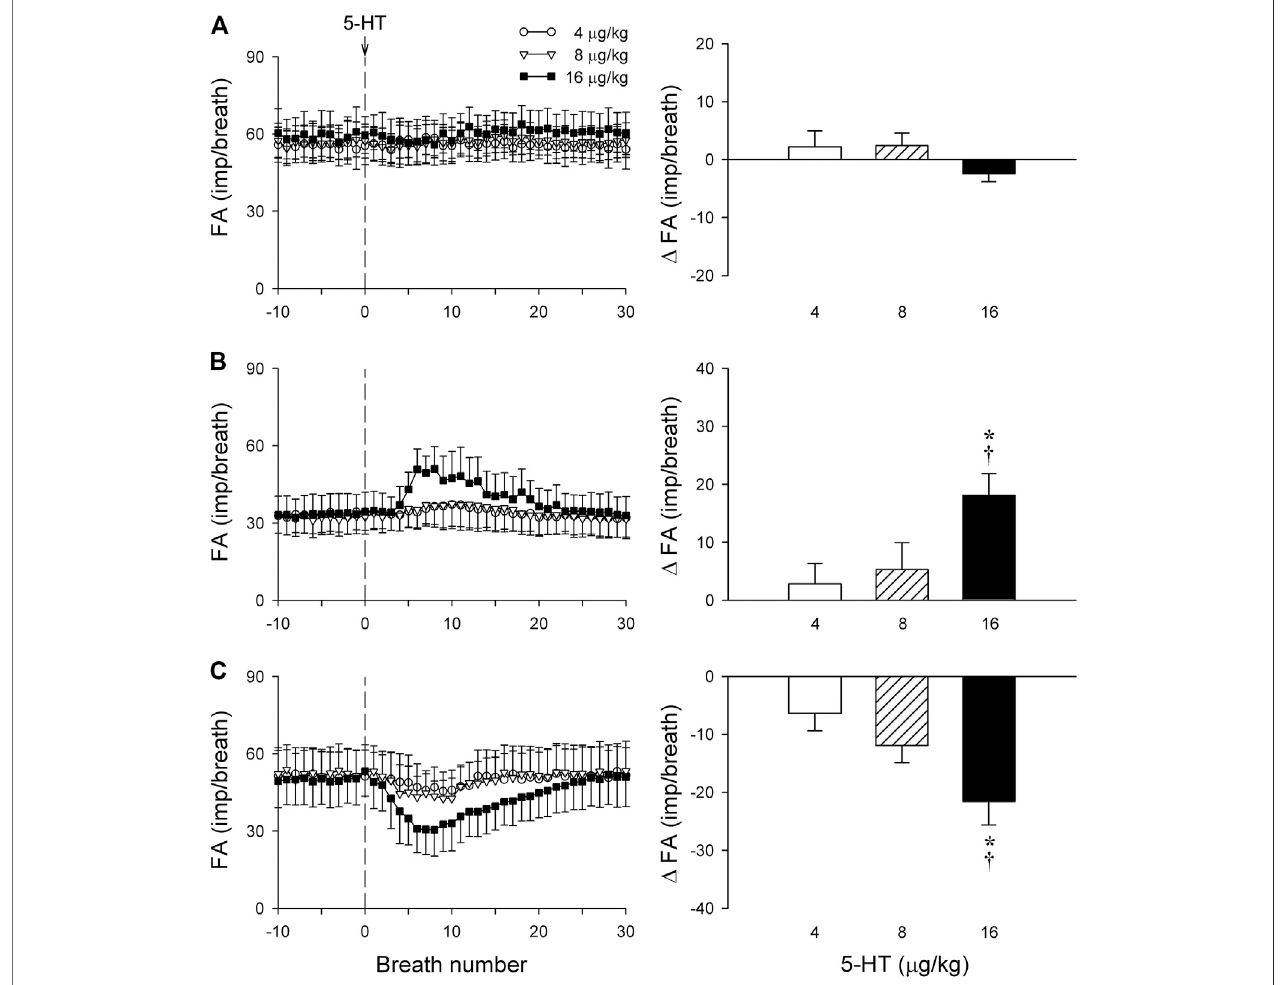
FIGURE7| ThesamegroupofSARsin Figure6 (n=17)weredividedintothreesubgroupsbasedupontheirdifferenttypesofresponsesto5-HT: (A) noresponse to 5-HT (n = 5); (B) delayed stimulation (n = 6); (C) delayed inhibition (n = 6). Only one SAR was studied in each animal. Left panels: histograms comparing the FA responsesto i.v. injection ofincreasingdoses of 5-HT (4, 8 and 16 μ g/kg);right panels: peak responsesofFA ( Δ FA)to the same three doses of5-HT injections. *and † , signi fi cantly different ( p < 0.05) from the responses to 4 and 8 μ g/kg of 5-HT, respectively. Data are means ± SEM. See the legend of Figure 2 for detailed